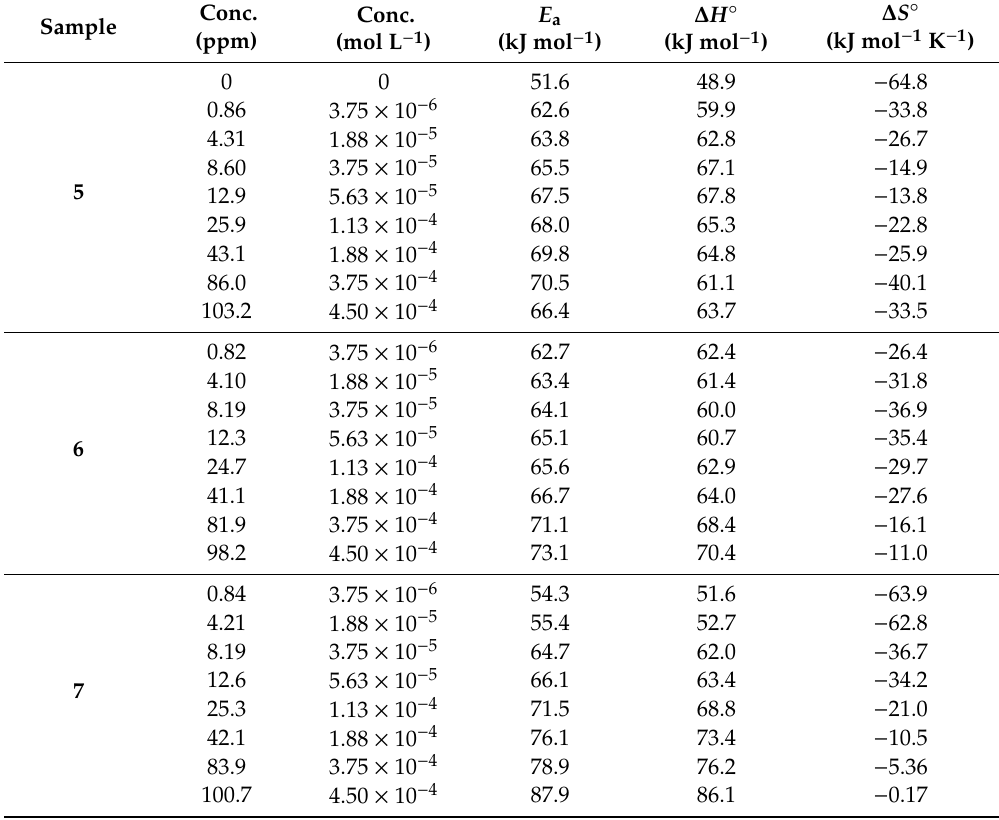
Table 3. Activation parameters for mild steel in 1 M HCl solution without and with corrosion inhibitors 5 – 7 obtained from gravimetric weight loss